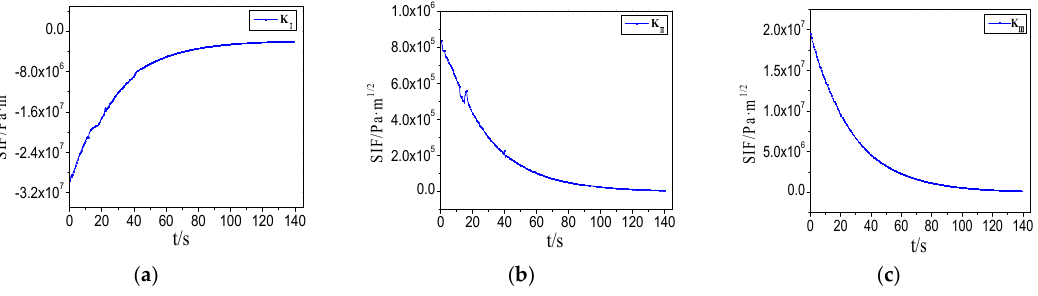
Figure 21. The stress intensity factors (SIFs) of the crack in the cooling process. ( a ) K I ; ( b ) K II ; ( c ) K III .